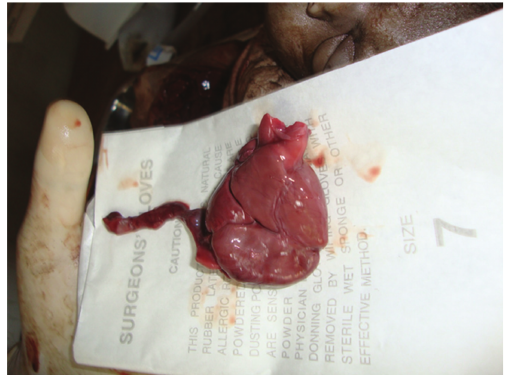
Figure 3: Photograph of single enlarged heart.